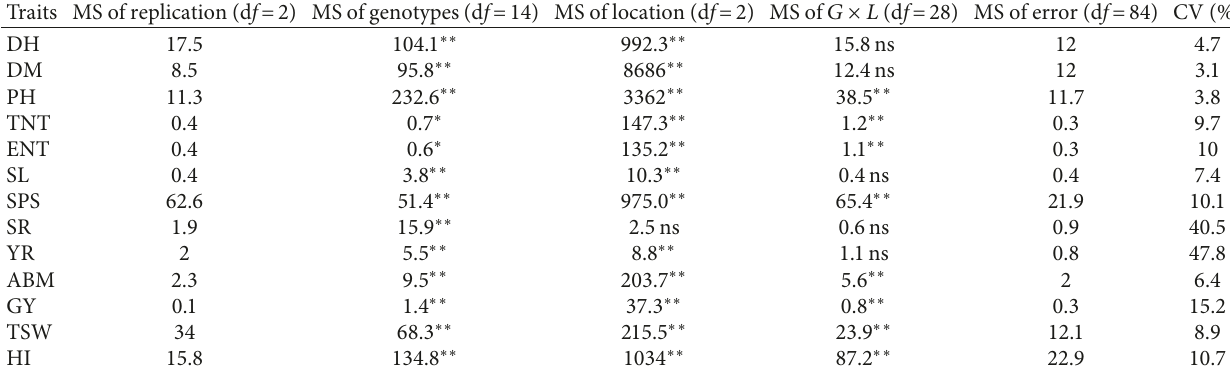
Table 3: Mean squares of the combined ANOVA for grain yield, components of yield, stem rust, and yellow rust disease severity for the 15 bread wheat genotypes tested across three